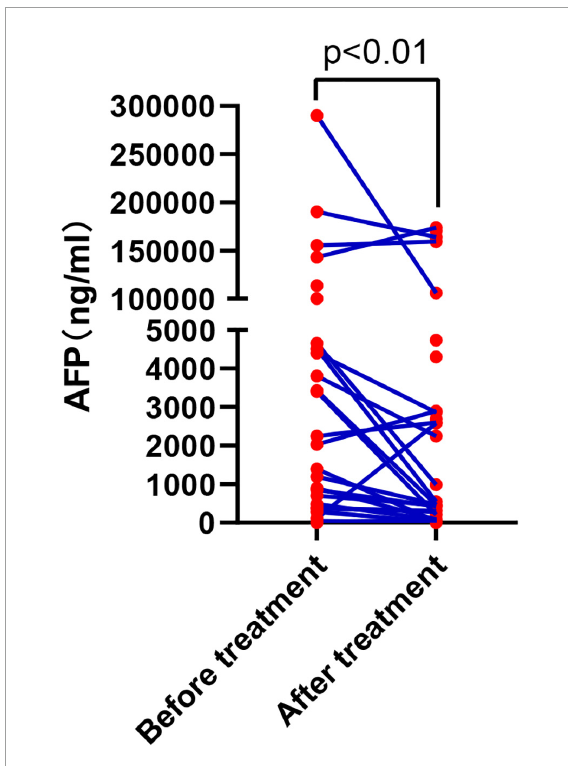
FIGURE6 Variation in AFP level before and after the first combined treatment.